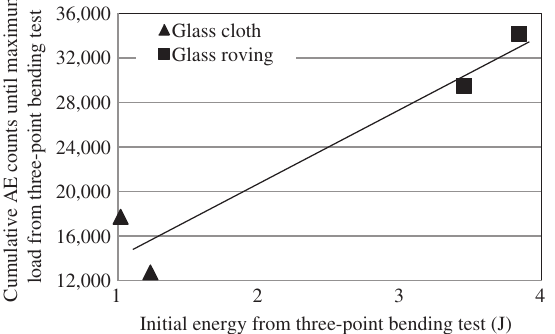
Figure 12 Relationship between cumulative AE counts and initial energy from the three-point bending